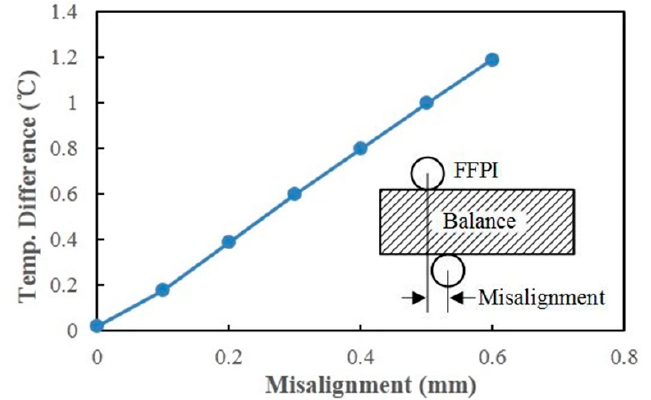
Figure 12. Simulated temperature difference between the positions of FFPIs 1 and 2, as a function of misalignment along the balance axial plane.